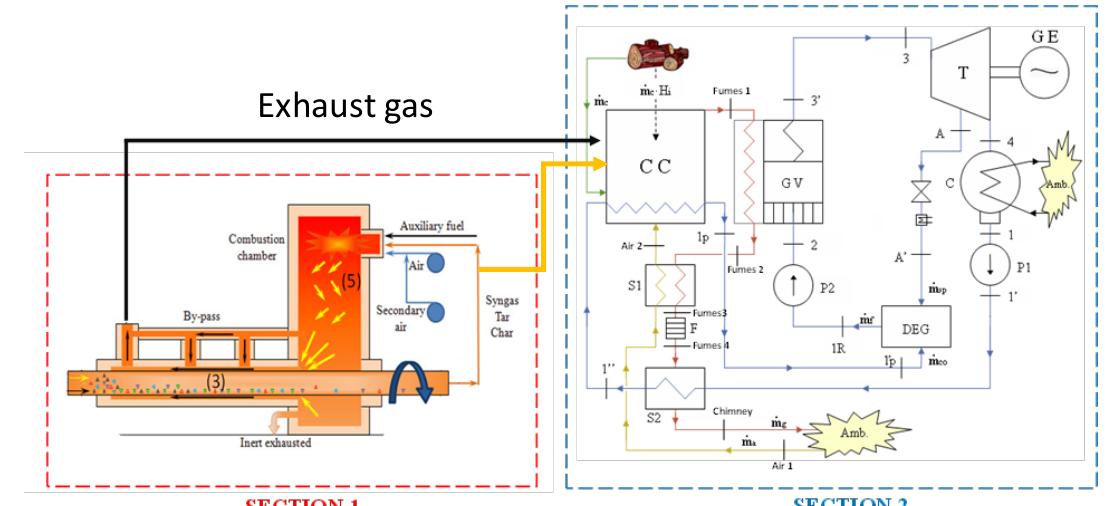
Figure 11. Configuration of whole gasifier-biomass steam power plant [54].